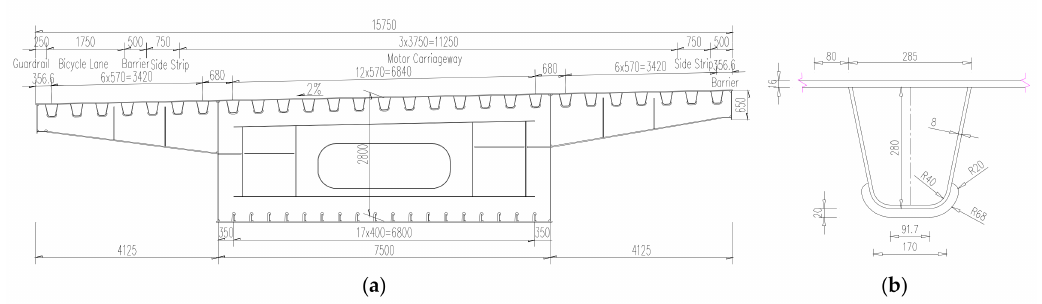
Figure 1. Design drawing of test bridge: ( a ) Cross section of steel box girder; ( b ) Connection detail of the longitudinal and transverse ribs (unit: mm).